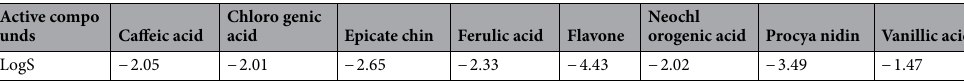
Interaction Energies (Van der Waals + electrostatic potential